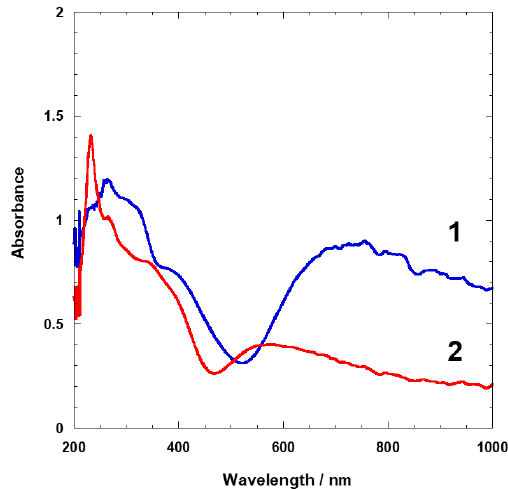
Figure 1. UV-Vis spectra of 1 (blue line) and 2 (red line) in the sold state. 2 was obtained by the reaction of Cu(NO 3 ) 2 · 3H 2 O and the bpba ligand in a methanol/water solution under aerobic conditions at room temperature, and a 55% yield was observed. Strong absorption of the coordinated nitrate anions at 1384 cm − 1 (antisymmetric stretching mode) was observed in the IR spectrum of 2 in KBr [32]. The signals for the C– H bonds of the bpba ligand were detected at 3094–2926 cm − 1 . Likewise, the VC = N peak was displayed at 1624 cm − 1 , which is also blue-shifted to that of the bpba ligand by the coordi- nation of Cu(II) ion. A distinct absorption band in the range of 215–430 nm, with maxima